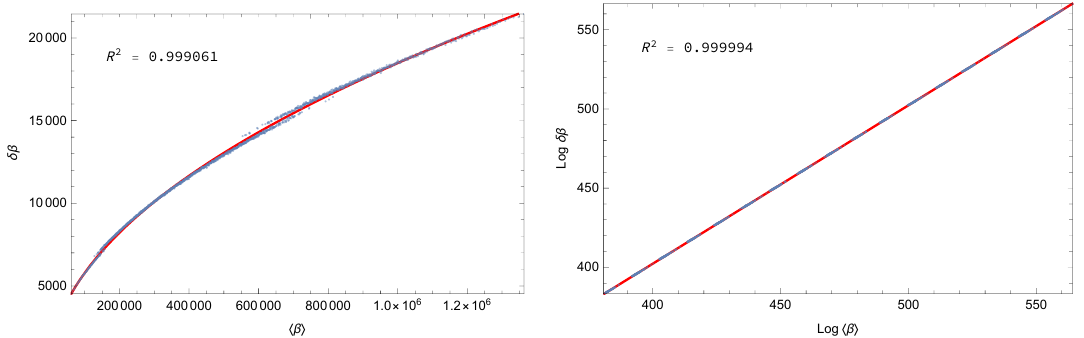
Figure 8 . Numerical calculation of the expectation value h β i and the variance δβ . Left: taking σ q = 10 and σ p = 10 − 5 , with fixed ¯ p 1 = 0 . 856 and ¯ p 2 = 1 . 3486 and with ¯ q i going from − 100 σ q to 100 σ . For each value of ¯ q a random sample of 50000 values has been chosen. Right: taking σ = 2 . 7 q i p and σ = 10 − 5 , with fixed ¯ q = 2 . 856 and ¯ q = 1 . 348 and with ¯ p going from − 100 σ to 100 σ . For q 1 2 i p p each value of ¯ p a random sample of 50000 values has been chosen. The scale is logarithmic in both i axes. The R 2 of the model fit is included in both